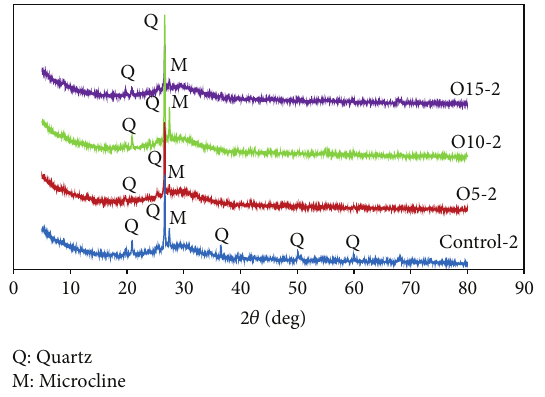
Figure 11: XRD pattern of geopolymer containing 5%